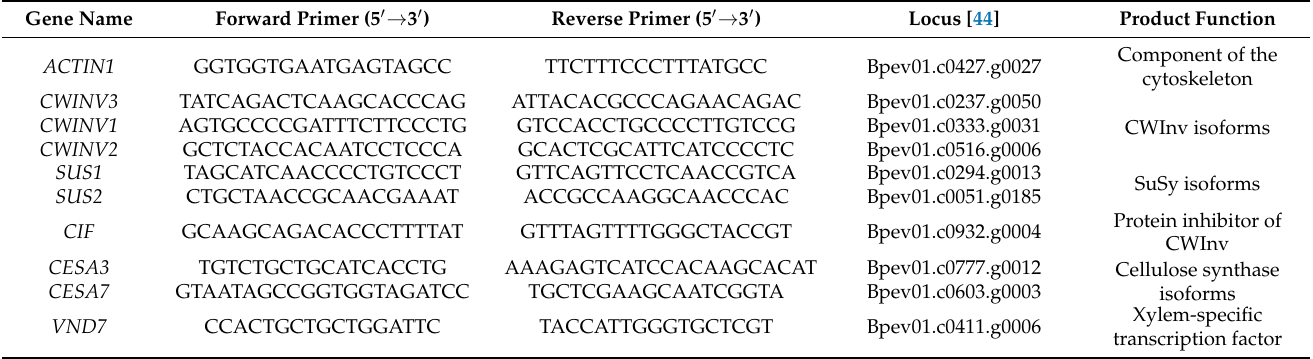
Table 1. Nucleotide sequence of primers for real-time PCR and brief characterization of target and reference